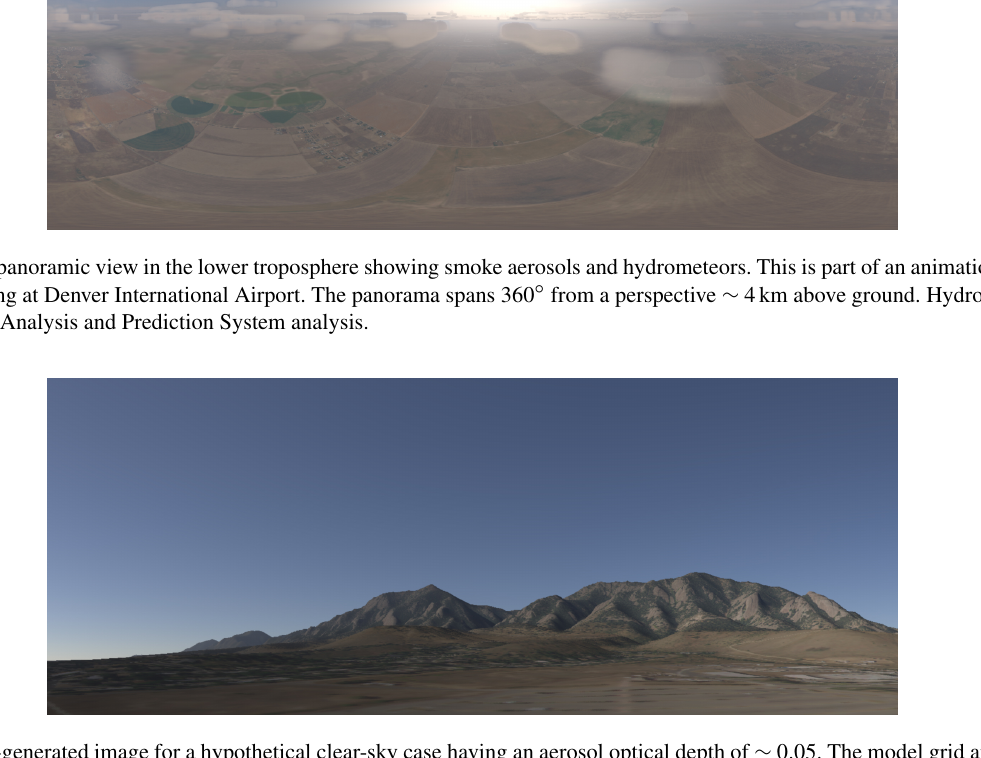
Figure 8. SWIm-generated image for a hypothetical clear-sky case having an aerosol optical depth of ∼ 0 . 05. The model grid and associated terrain data are at 30m resolution, and surface spectral albedo information is derived from 0.7m resolution aerial imagery from the USDA. The vantage point is from the US Department of Commerce campus in Boulder, Colorado, looking at azimuths from south through